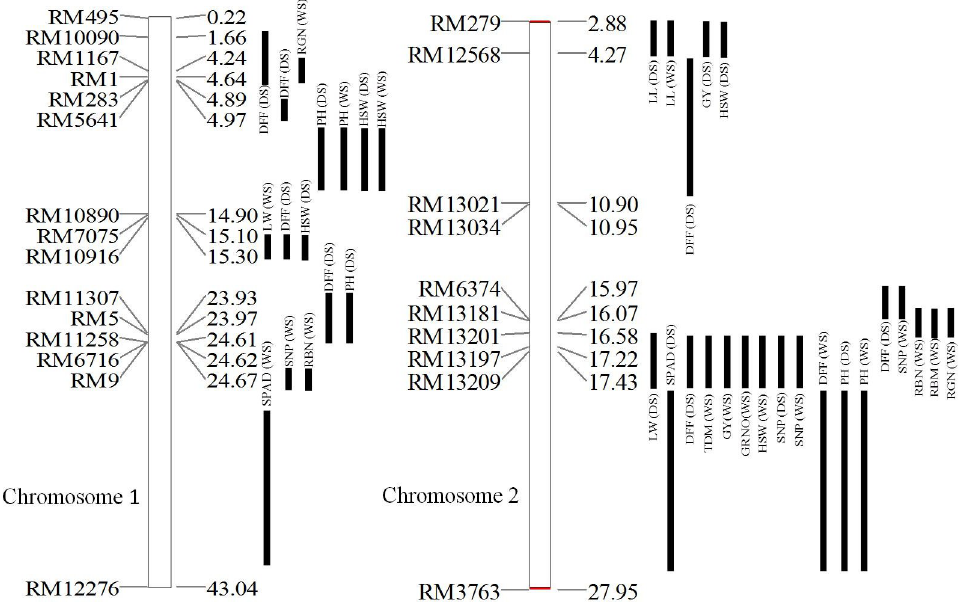
Fig 3. Local linkage map of chromosomes 1 and 2 with identified QTL under LN. WS: Wet season, DS: Dry season, SPAD: SPAD value, LL: leaf length (cm), LW: leaf width (cm), DFF: days to 50% flowering, PH: plant height (cm), GRNO: grain number, HSW: hundred seed weight (g), GY: grain yield per plant (g/plant), TDM: total dry matter (g/ plant), SNP: straw nitrogen percent, RBM: relative biomass yield, RGN: relative grain nitrogen, RBN: relative biomass